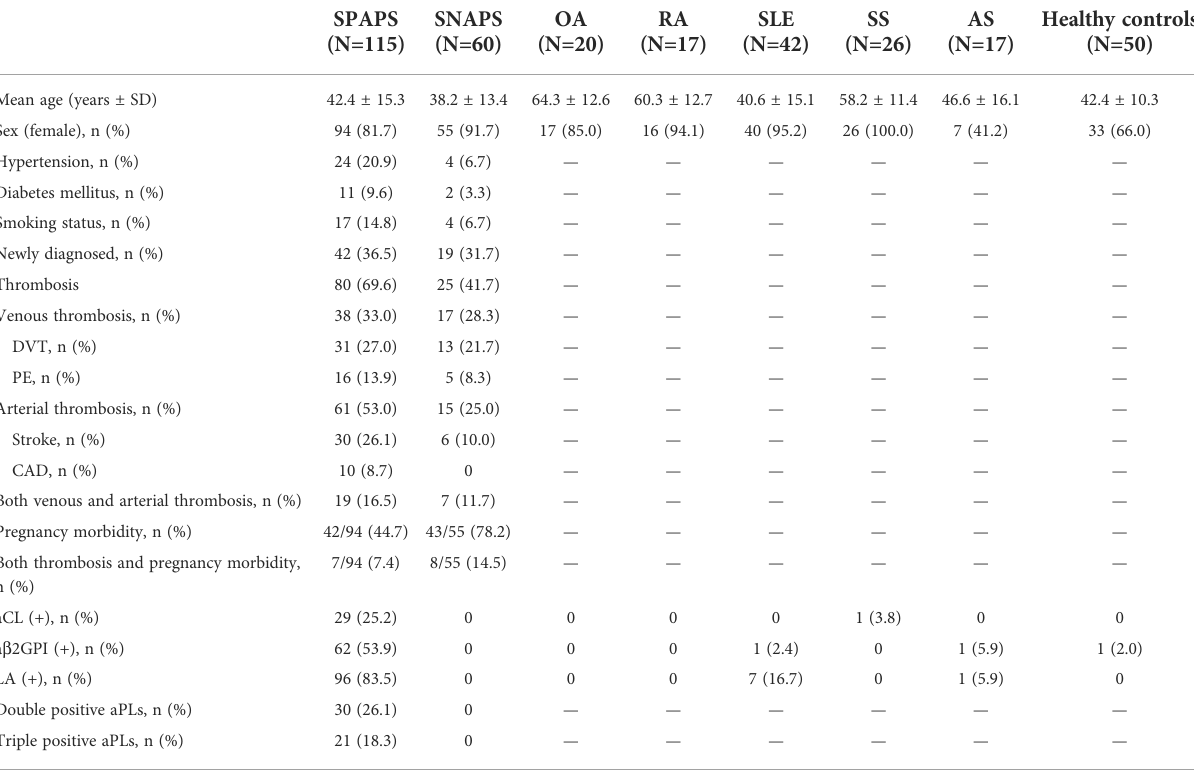
SPAPS, seropositive antiphospholipid syndrome; SNAPS, seronegative antiphospholipid syndrome; OA, osteoarthritis; RA, rheumatoid arthritis; SLE, systemic lupus erythematosus; SS, Sjögren ’ s syndrome; AS, ankylosing spondylitis; DVT, deep venous thrombosis; PE, pulmonary embolism; AT, arterial thrombosis; CAD, coronary atherosclerotic heart disease; LA, lupus anticoagulant; aPLs, antiphospholipid